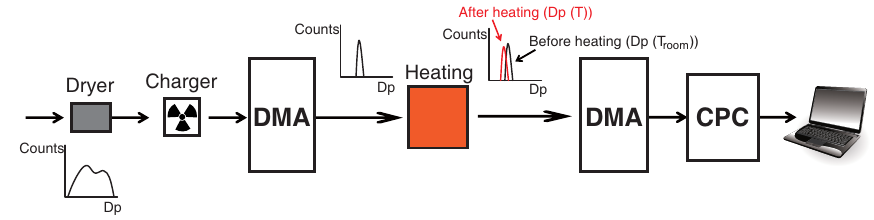
Figure 1. Schematic view of the VTDMA